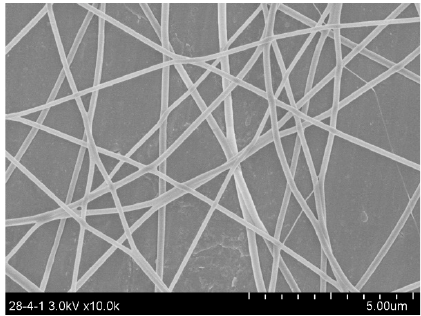
Figure 5. The SEM image of the nonwoven sample with straight fibers.